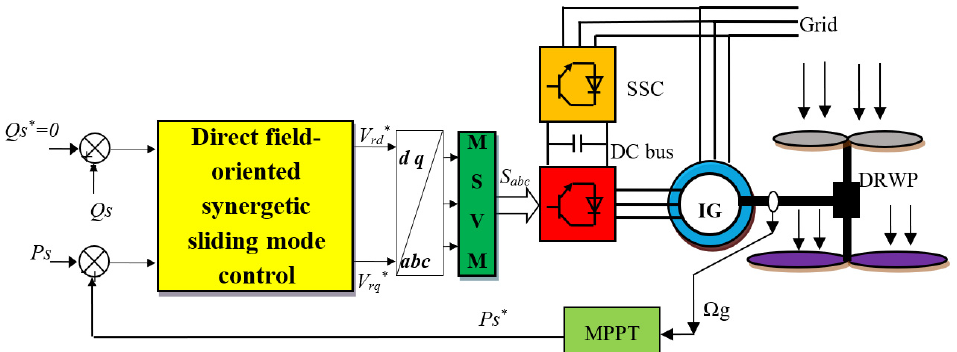
Figure 5. Direct FOC-SSMC control of the IG-based DRWP system.